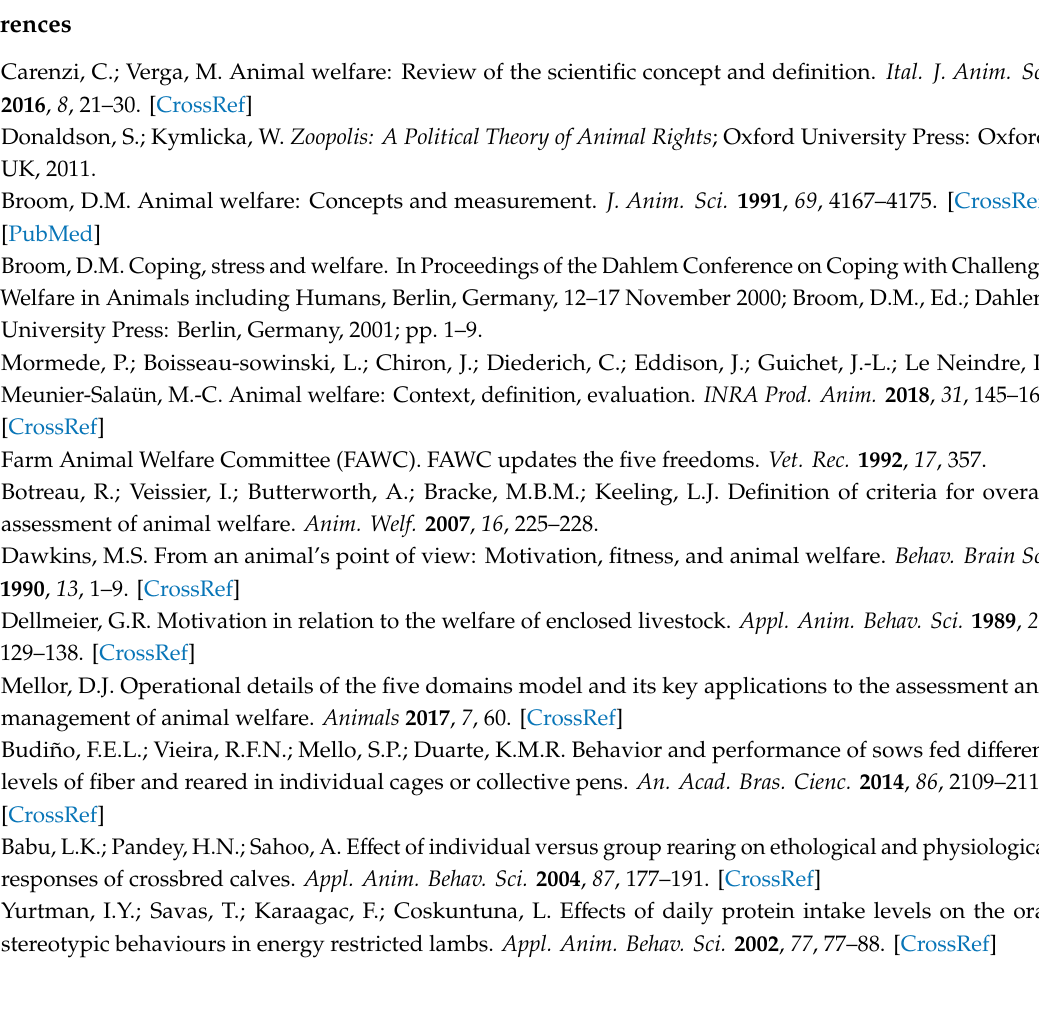
Table S1: Descriptive statistics of the categorical factors in the